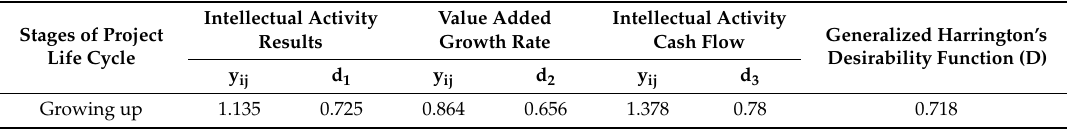
Table 9. An example of standard mark interpretation on the Harrington’s scale for Project 2 in accordance with the life cycle stage.